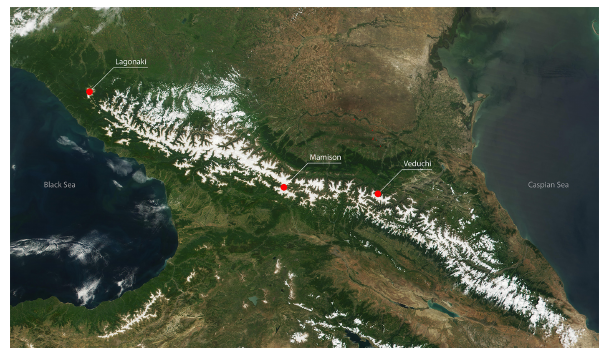
Figure 1. The North Caucasus mountain system. Locations of Veduchi (42 ◦ 41 (cid:48) 5 (cid:48)(cid:48) N, 45 ◦ 34 (cid:48) 7 (cid:48)(cid:48) E), Mamison (42 ◦ 42 (cid:48) 20 (cid:48)(cid:48) N, 43 ◦ 47 (cid:48) 40 (cid:48)(cid:48) E) and Lagonaki (44 ◦ 3 (cid:48) 0 (cid:48)(cid:48) N, 40 ◦ 0 (cid:48) 0 (cid:48)(cid:48) E) regions.